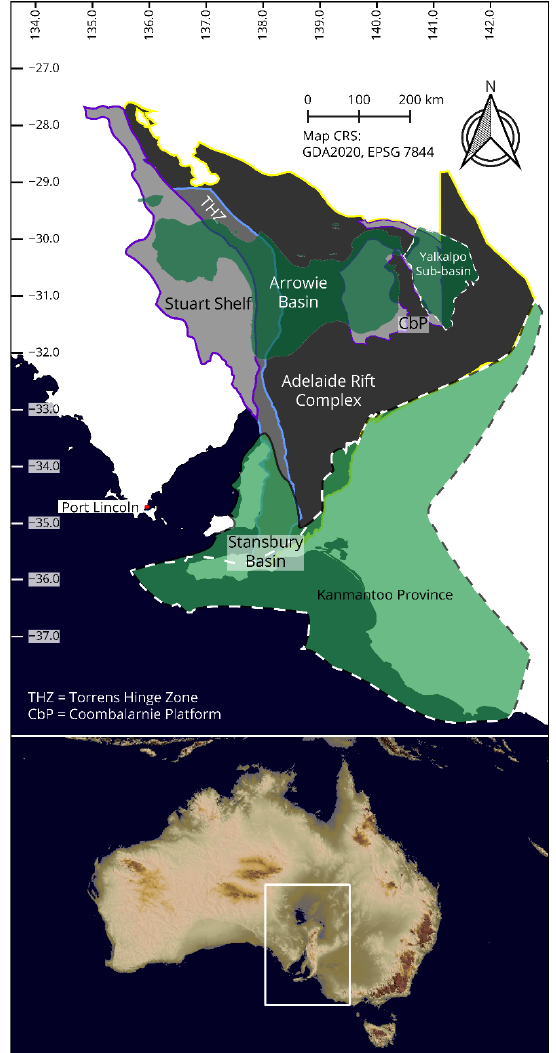
Figure 1. Map of the known Adelaide Superbasin extent and basin subdivisions, derived from